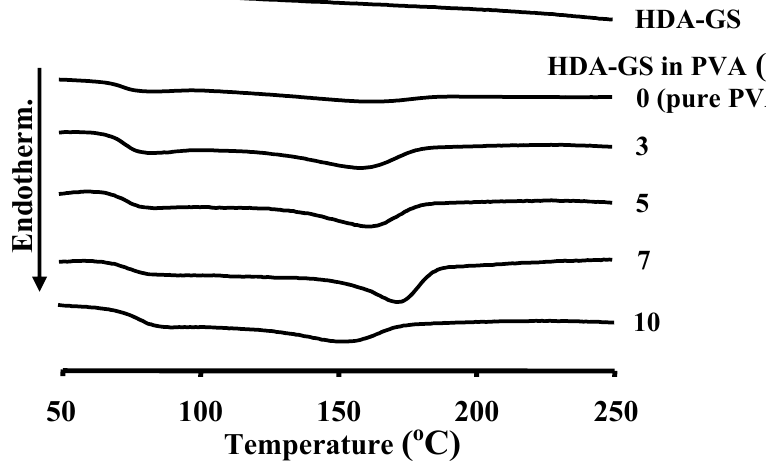
Figure 8. DSC thermograms of PVA hybrid films with various HDA-GS contents.